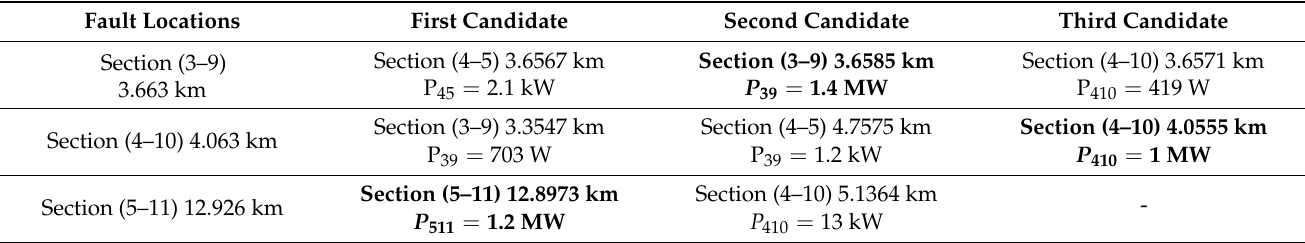
Table 1. Proposed Method Effectiveness under Different Fault Locations.